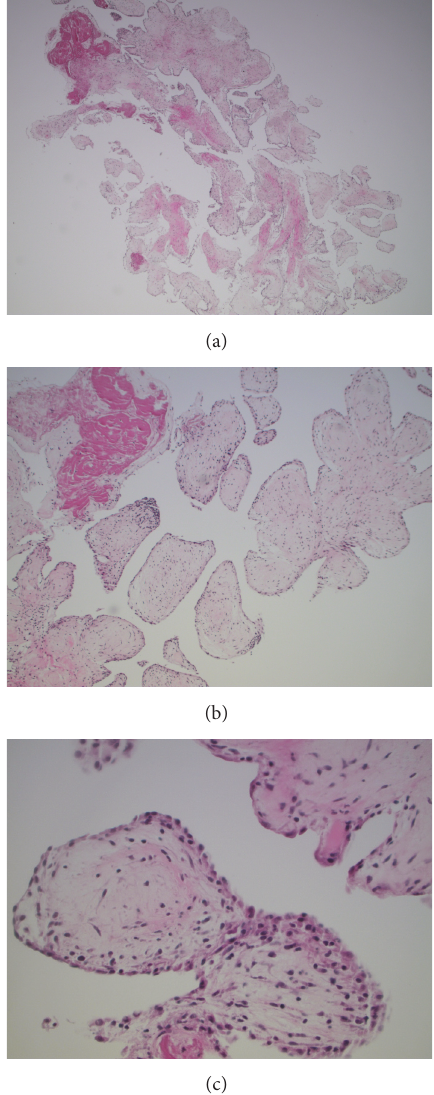
Figure 5: (a) H&E 40x reveals multiple papillary structures lined by endothelial cells; (b) H&E 100x reveals the papillary structures are avascularandcontainfibromyxoidstroma;(c)H&E400xrevealsthe papillary structures are lined by bland endothelial